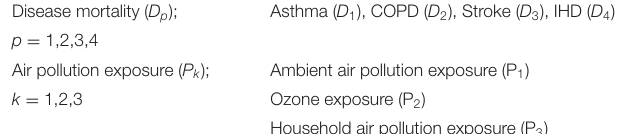
TABLE 2 | Defining the decision variables/parameters. Parameters Measuring grey correlation between mortality (asthma, COPD, stroke, IHD) and associated risk factors Disease mortality ( D p );